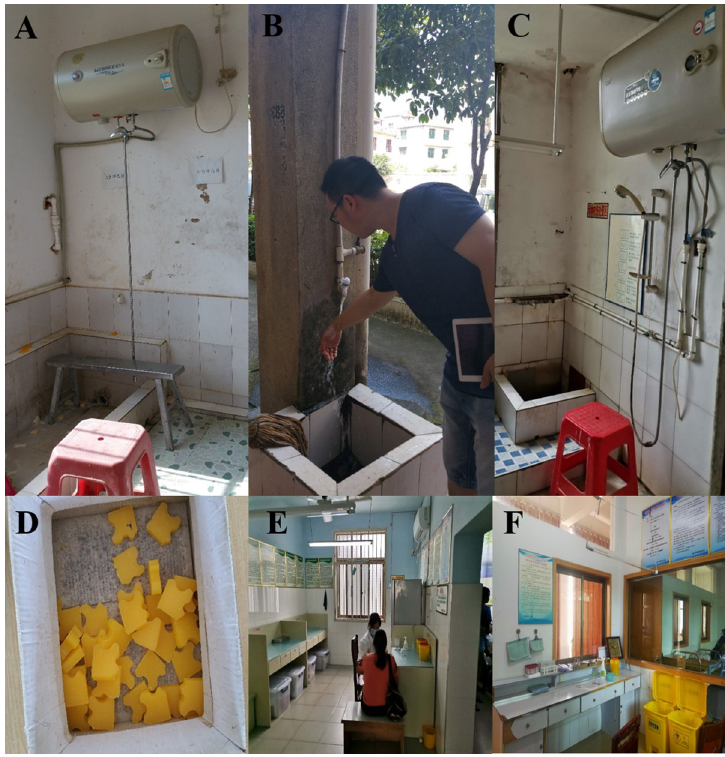
Fig 2. Snapshots from rabies PEP clinics in project county A, Hunan Province, China, July–August, 2016. (A) Facility for wound washing at the urban clinic. (B) Facility for wound washing at a rural clinic. (C) Facility for wound washing at a second rural clinic. (D) Soap used for wound washing at a rural clinic. (E) Area for vaccination and RIG administration at the urban clinic. (F) Area for vaccination at a rural clinic.